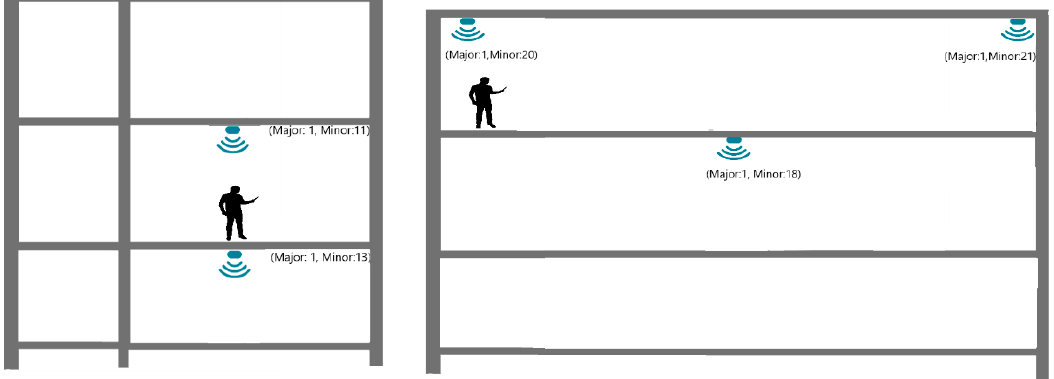
Figure 6. Test in the corridor (a green region in Figure 3): interference between floors with axis placed on the same vertical alignment ( Left ); interference between beacons placed along the axis of the corridor ( Right ).